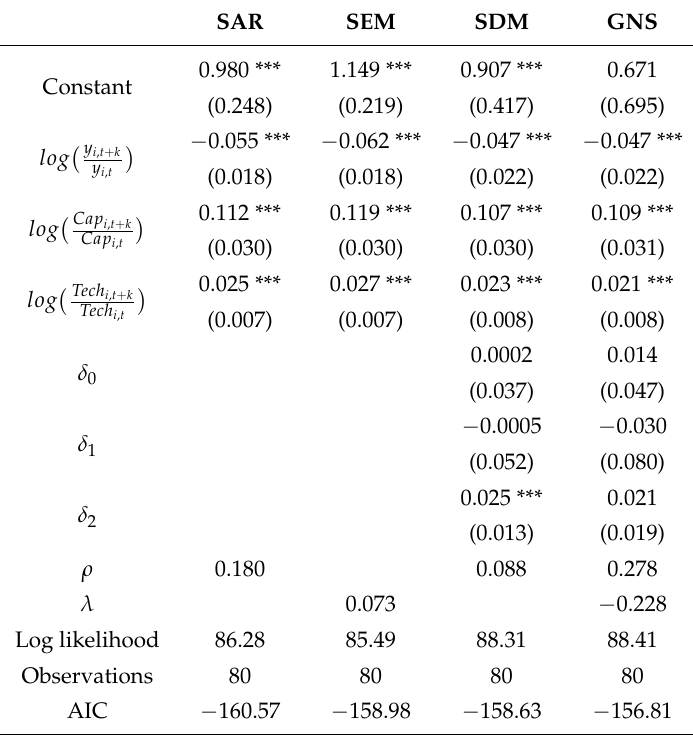
Table 3. Conditional β -convergence models for 2010–2014. The weight matrix is adjacency matrix.